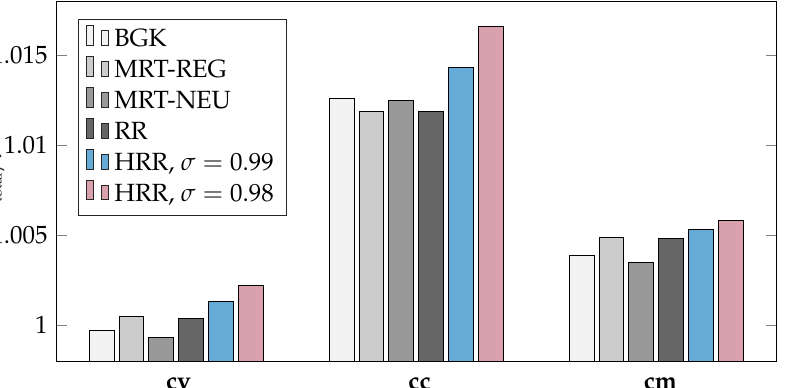
Figure 17. Comparison of ν total / ν for all collision models and grid layouts with ˜ ω c = 1.94990 (Re h , b = 67.53).